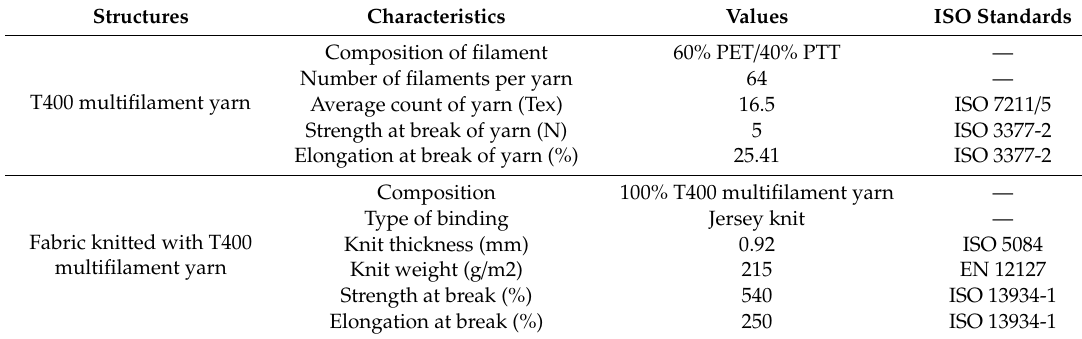
Table 1. Physical characteristics of T400 multifilament yarn and knitted fabrics.